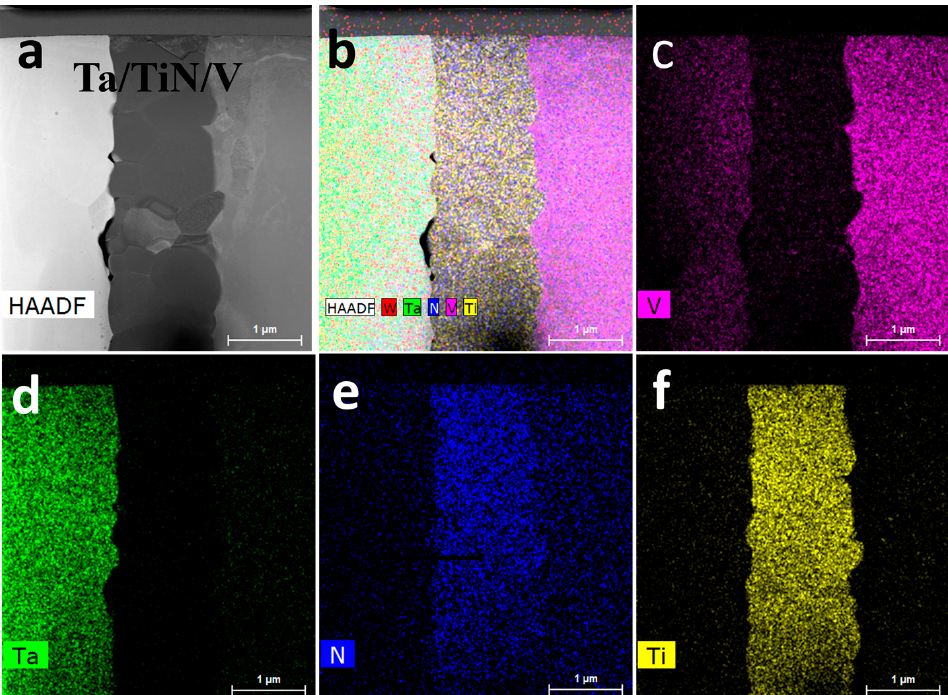
Figure 16. W/V/TiN/Ta-laminated composite joined at 1200 °C: ( a ) HAADF image, EDS mapping profile of ( b ) W, Ta, Ti, N, V, ( c ) V, ( d ) Ta, ( e ) N, and ( f ) Ti.